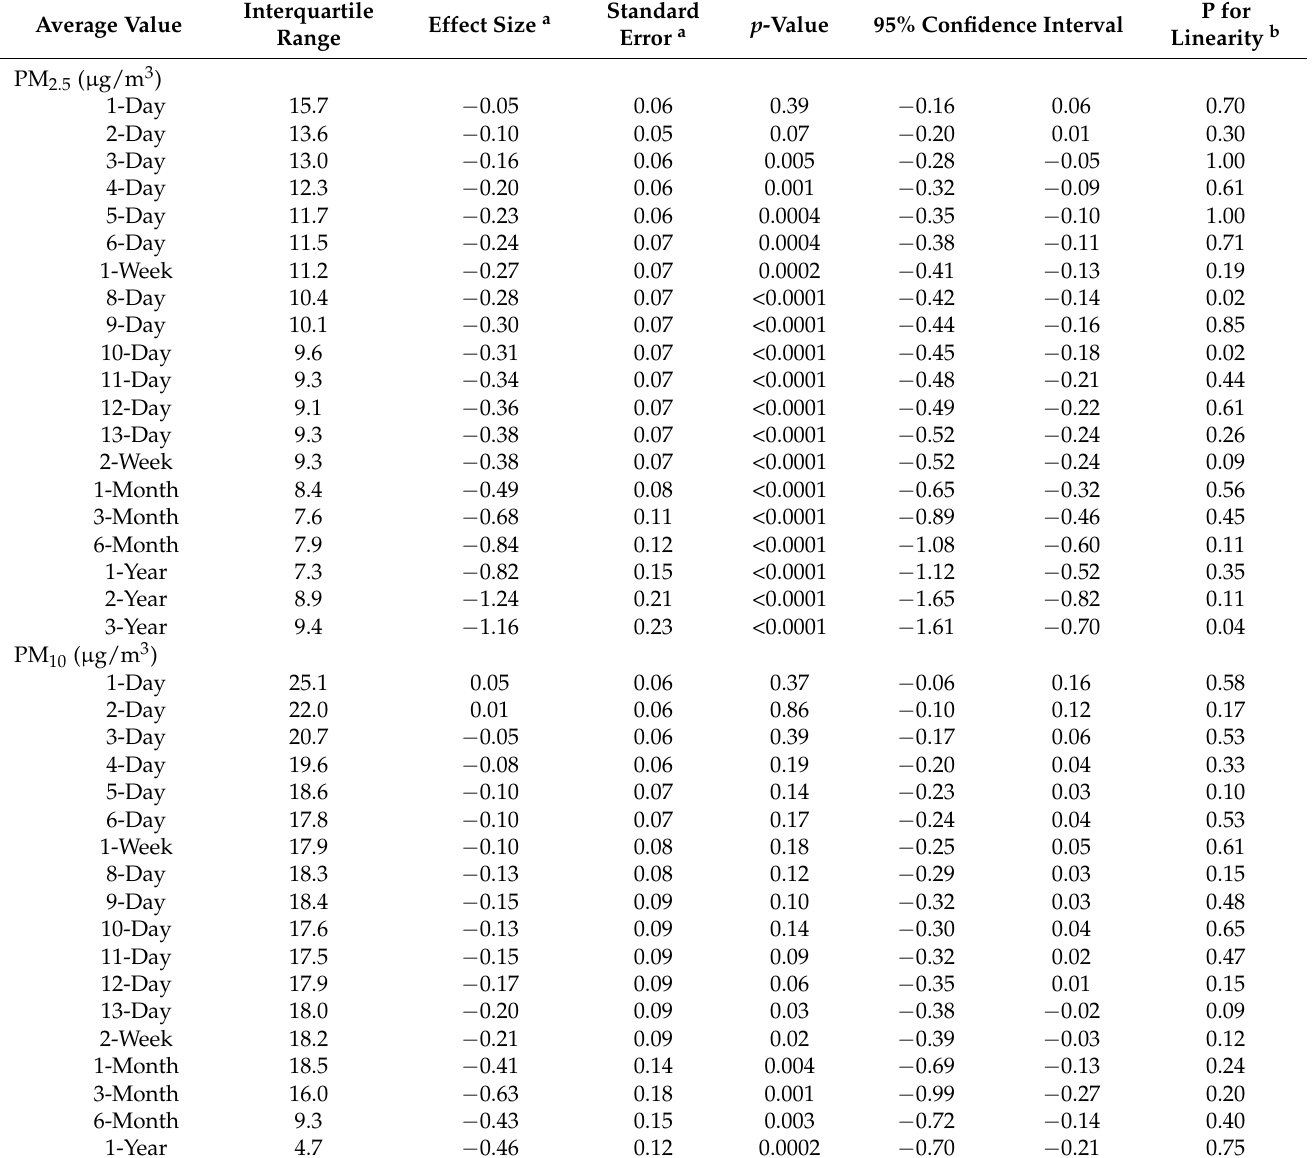
Table 4. Relationship between PM 2.5 and PM 10 and cognitive score (n =